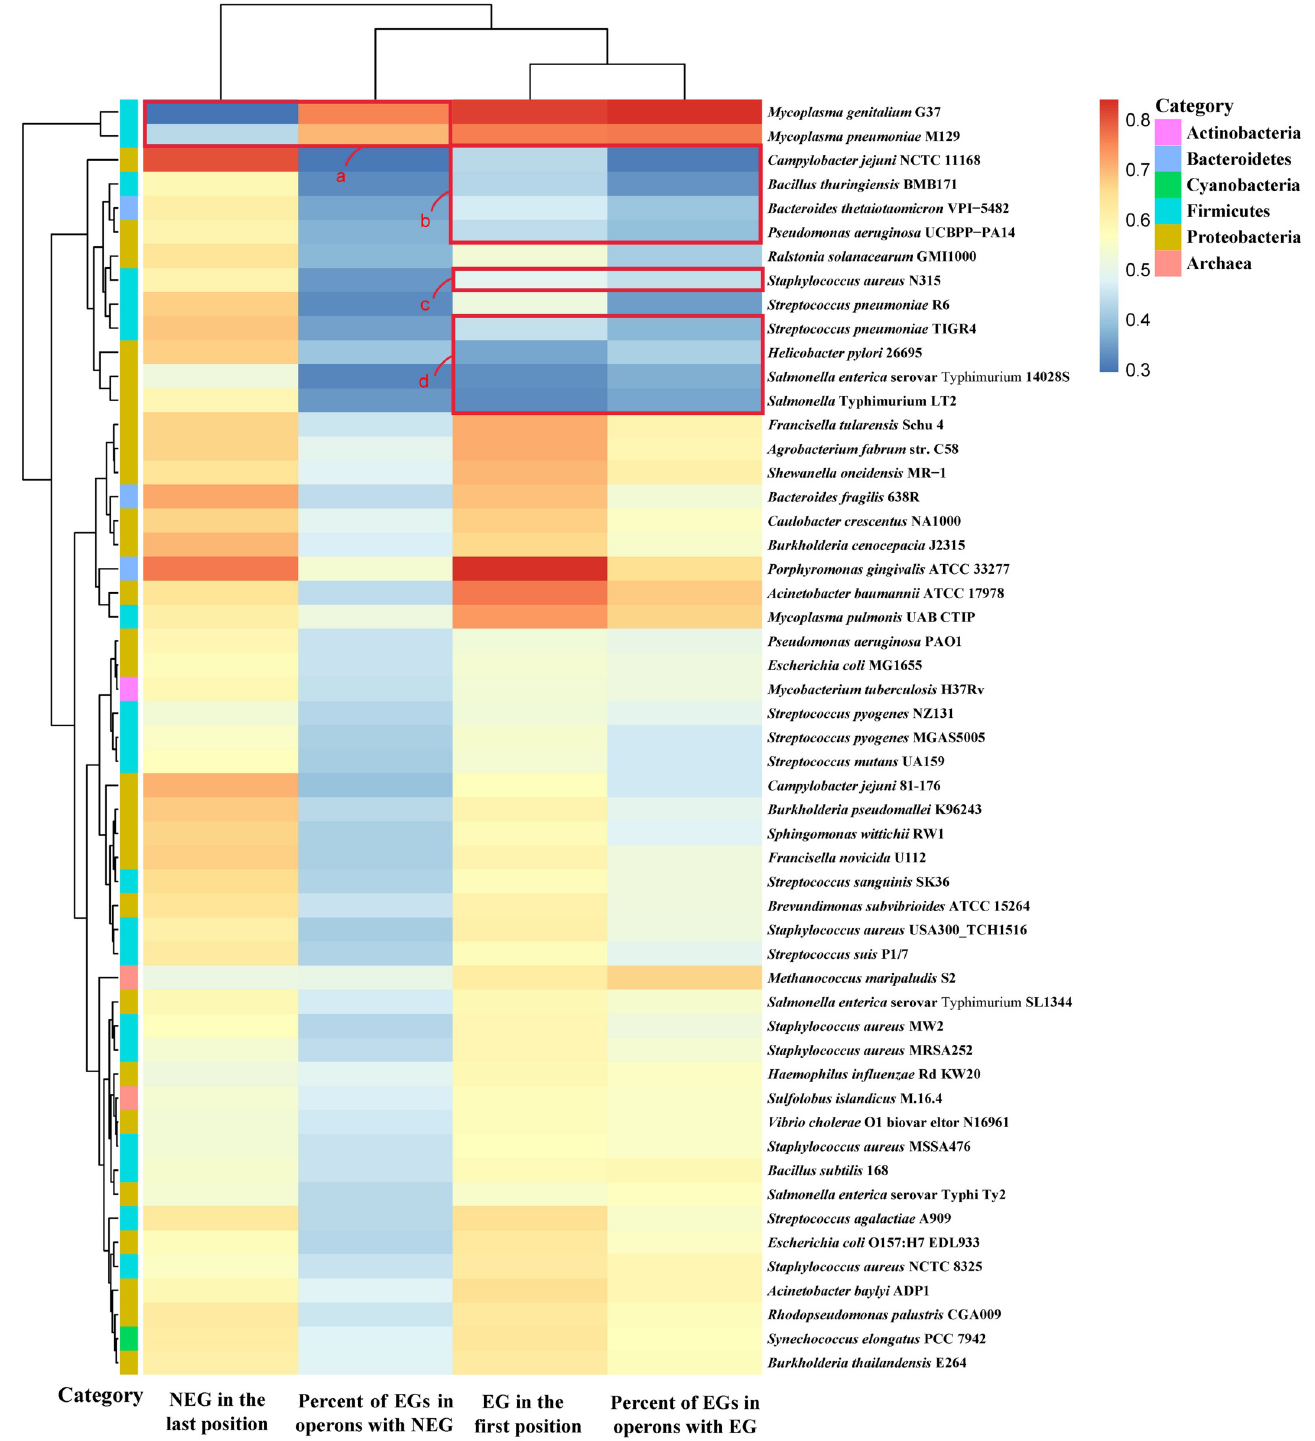
Fig 1. The relationship between distribution of essential and non-essential genes and proportion of essential genes. The heatmap was plotted using the heatmap function in the R package. The cells in the heatmap correspond to the proportion of genes under different conditions, and the value range is displayed in different colors. The color bar on the left side of the heatmap corresponds to the phylum classification of the species. Hierarchical clustering of analysis results in two dimensions is represented by a tree diagram. Species whose distribution of essential genes occupies the first position in less than 50% of operons are shown in red square boxes b-d, and species whose distribution of non-essential genes occupies the last position in less than 50% of operons are shown in red square box a.